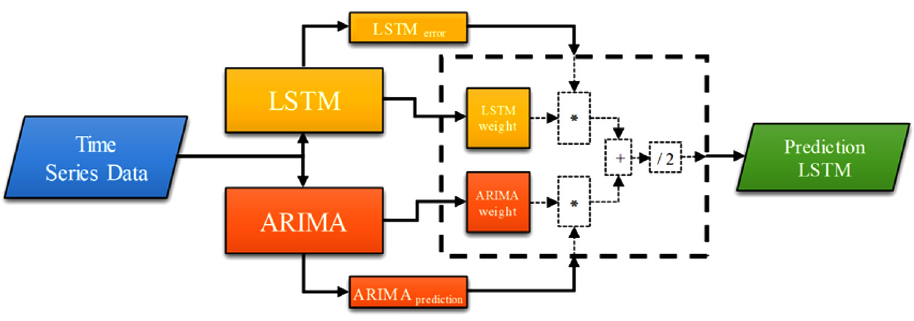
Figure 3. Hybrid model